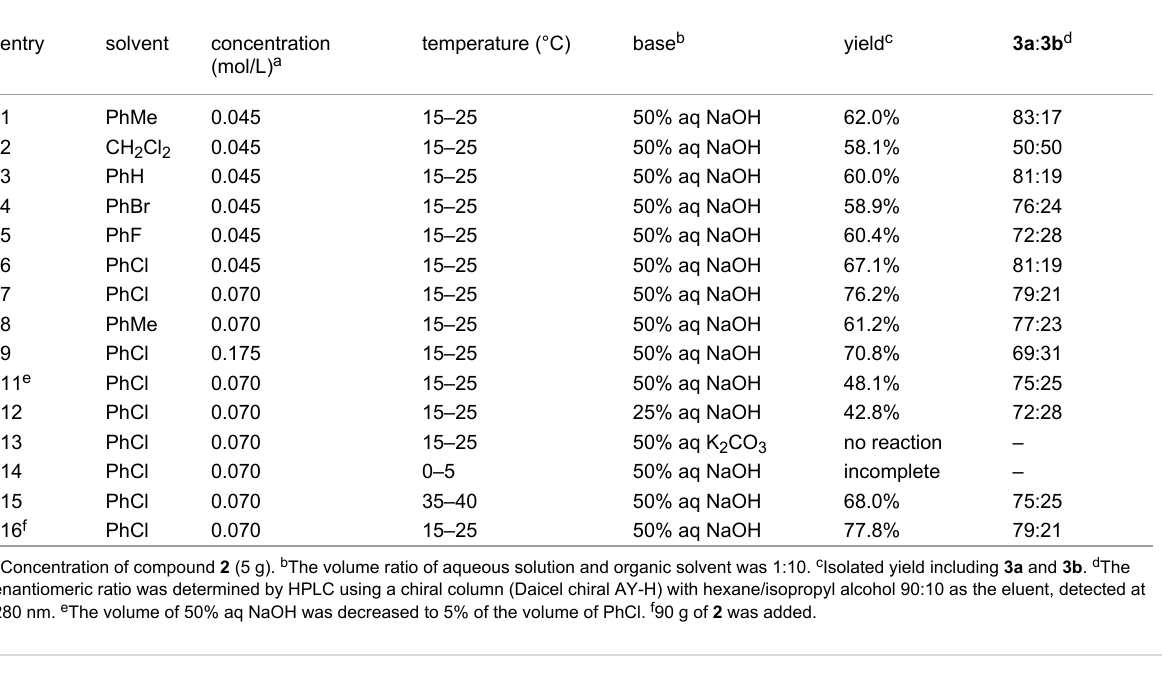
Table 2: Screening of catalytic conditions.